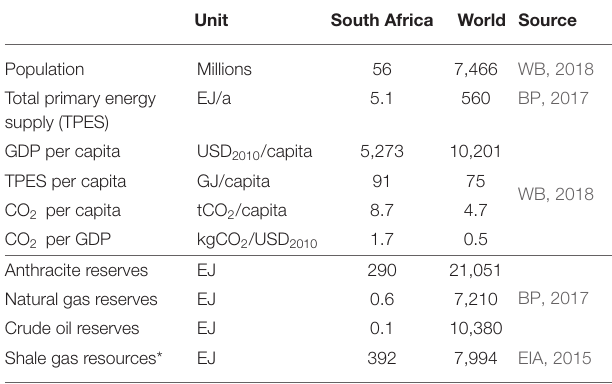
TABLE 1 | Key indicators on SA’s energy system in comparison to the world (all indicators refer to 2016).